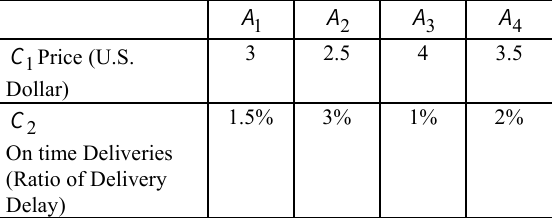
Table 7. Customers’ opinions represented and aggregated by the